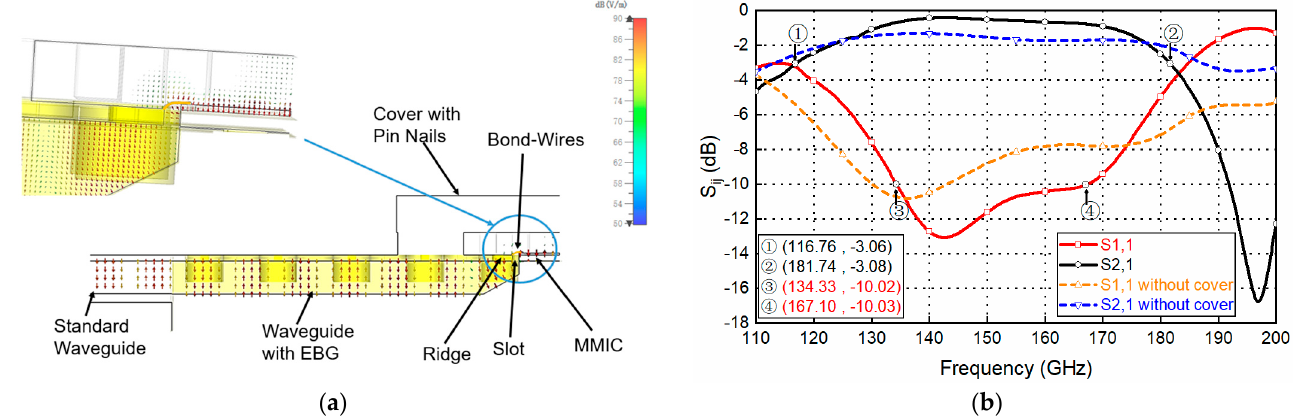
Figure 7. Substrateless transition. ( a ) E-field distribution of the transition; ( b ) simulated perfor-